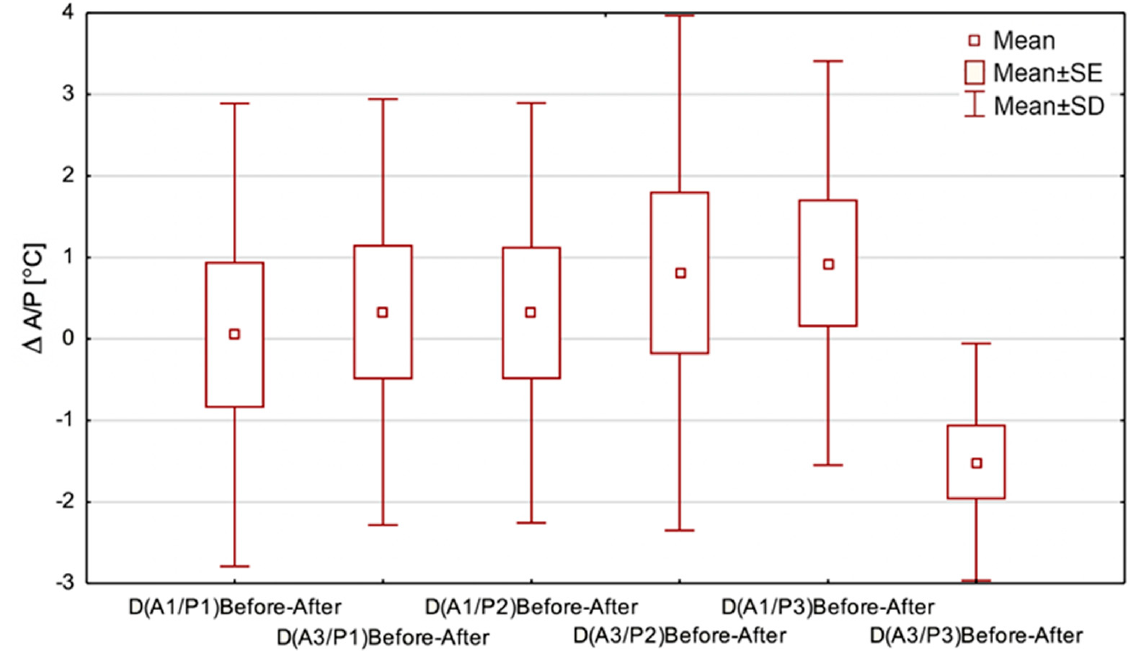
Figure 6. The temperature range changes in Area 1 and Area 3 during the three periods of THBOT, where, e.g., ∆ (A1/P1)Before-After is defined as (Tmax-Tmin) before THBOT—(Tmax-Tmin) after THBOT in Area 1 and Period 1. SE—standard error; SD—standard deviation.